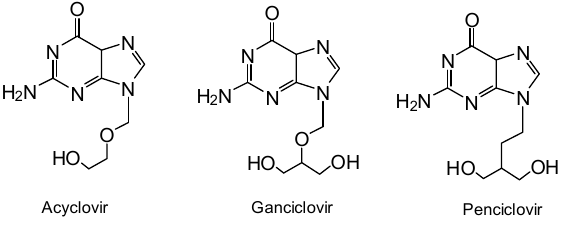
Figure 1. Acyclic nucleoside antiviral agents.